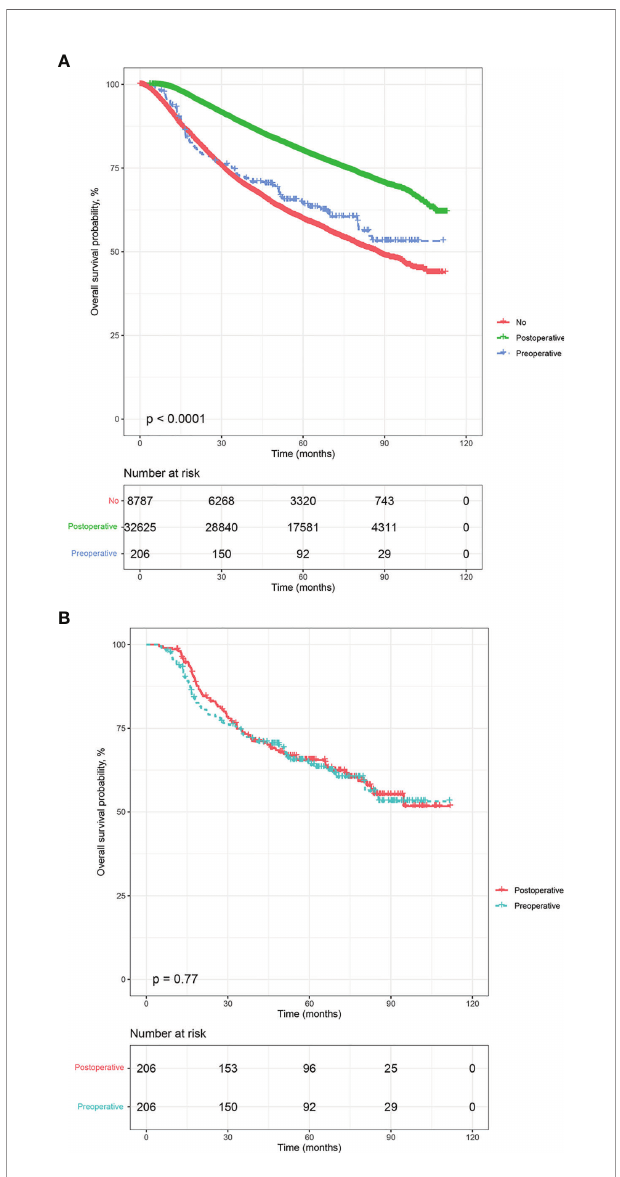
FIGURE 2 | Kaplan-Meier overall survival analysis, before and after propensity score matching. (A) all participants, (B) matched